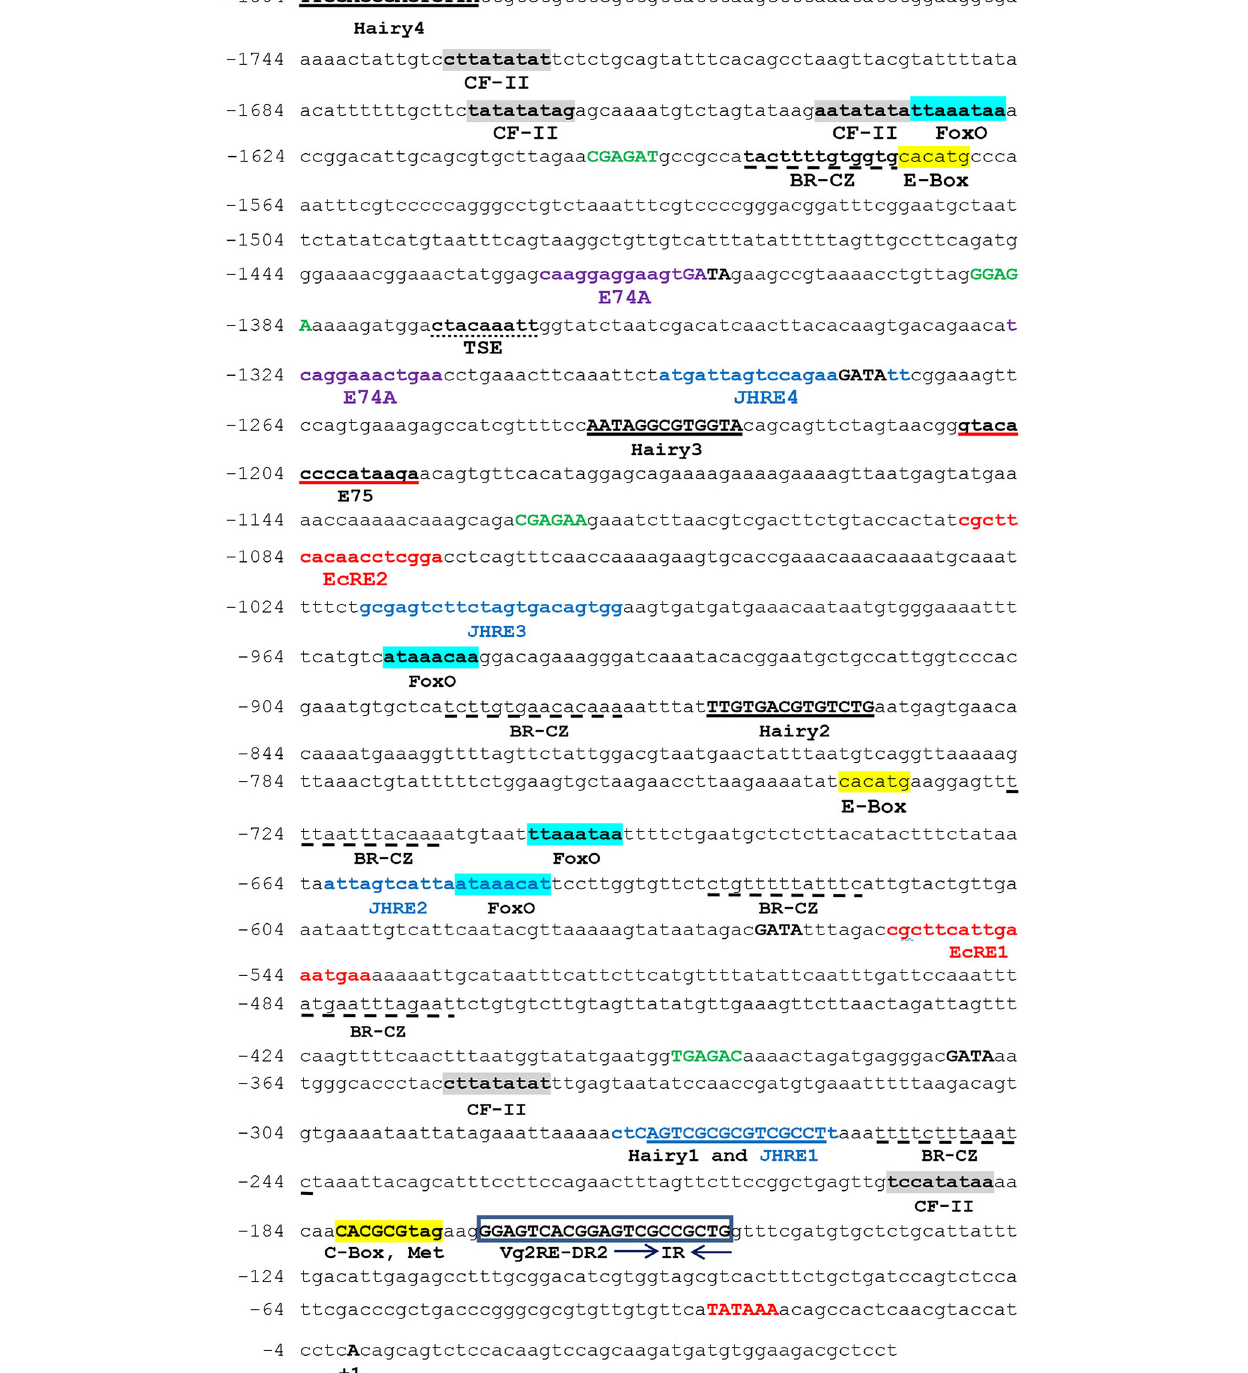
Frontiers in Physiology |